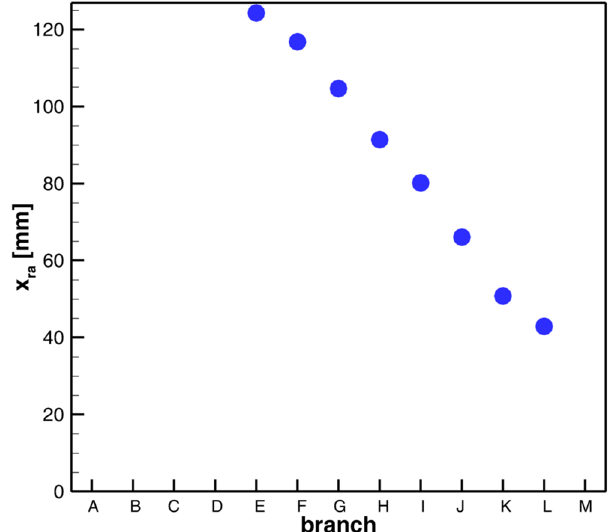
Fig. 7. Positions of the reattachment